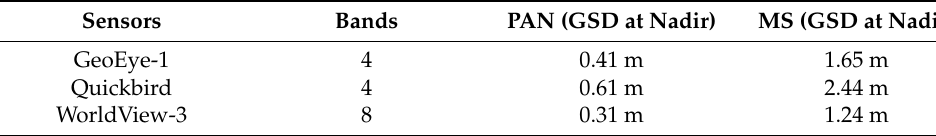
Table 1. The spatial resolution of datasets from different satellites. Sensors Bands PAN (GSD at Nadir) MS (GSD at Nadir) GeoEye-1